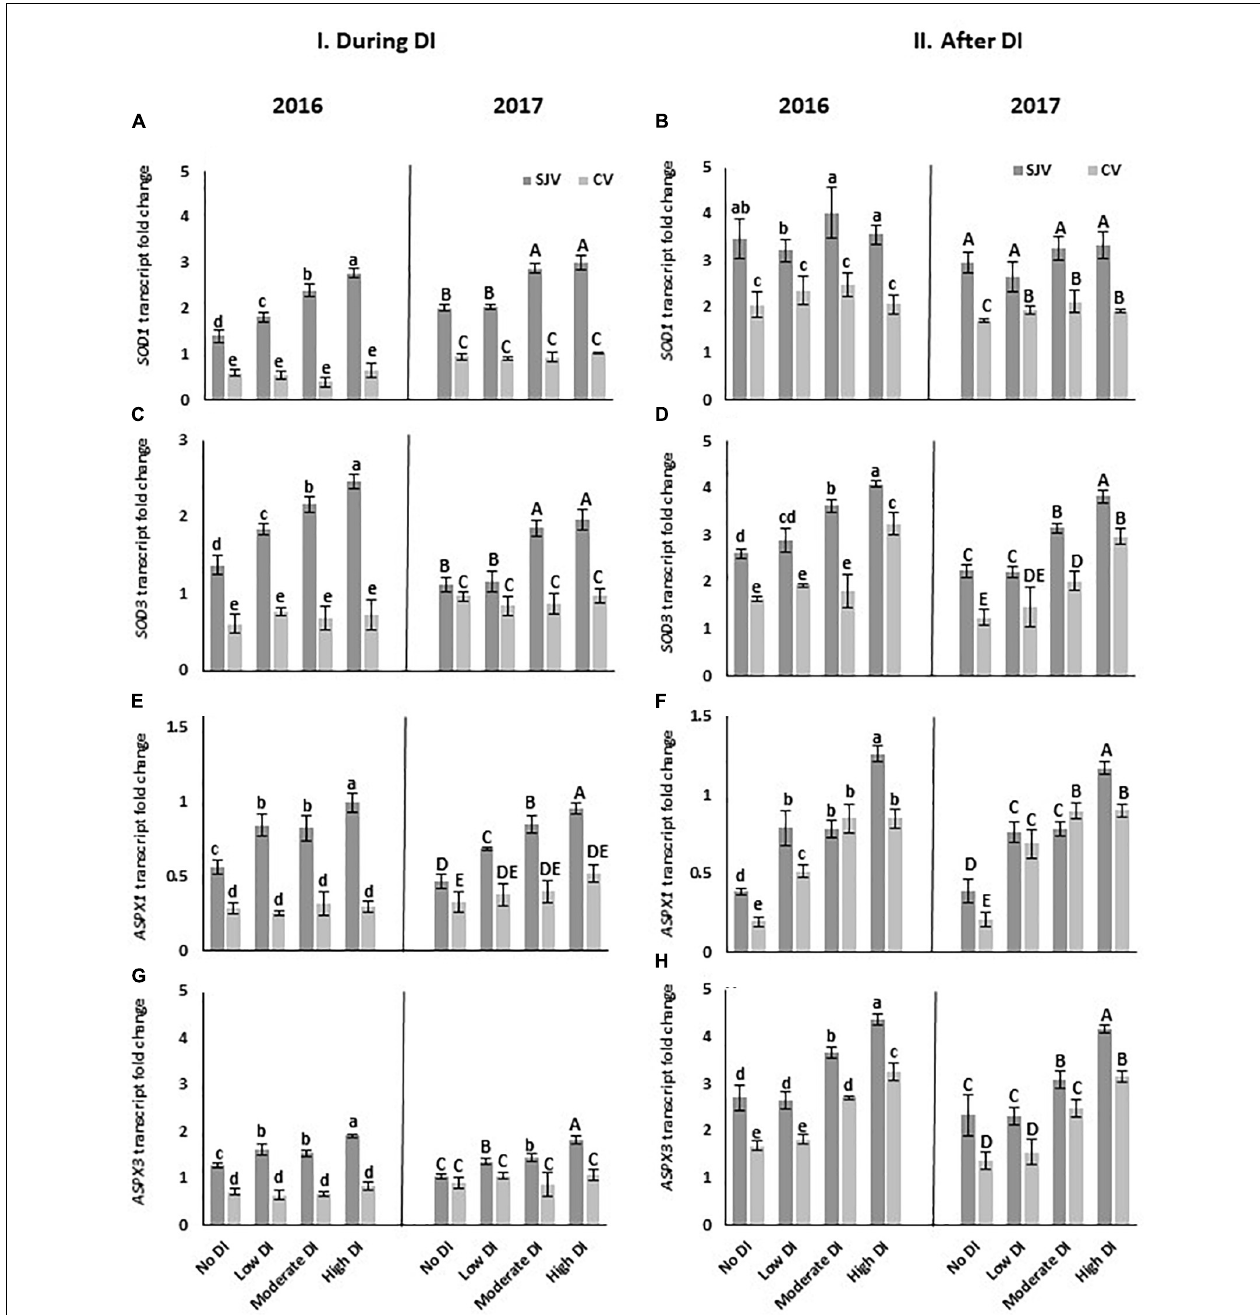
FIGURE 8 | Expression of genes involved in the antioxidant system pathway in Scarlet Royal berry skin as affected by deficit irrigation (DI) treatments in 2016 and 2017 in San Joaquin (SJV) and Coachella (CV) Valleys. Genes involved in the antioxidant system are: superoxide dismutase ( SOD1 and SOD3 ) (A–D) , and peroxidase gene ( ASPX1 and ASPX3 ) (E–H) . Gene expression was calculated during deficit treatment (I. During DI) and after re-irrigating vines with the original schedule (II. After DI). The error bars represent the standard deviation. Different letters on bars indicate significant differences among treatments and locations at p < 0.05 according to the Tukey HSD test within the same season. Different lower-case letters indicate a significant difference among treatments and locations in 2016 while capital letters are used for